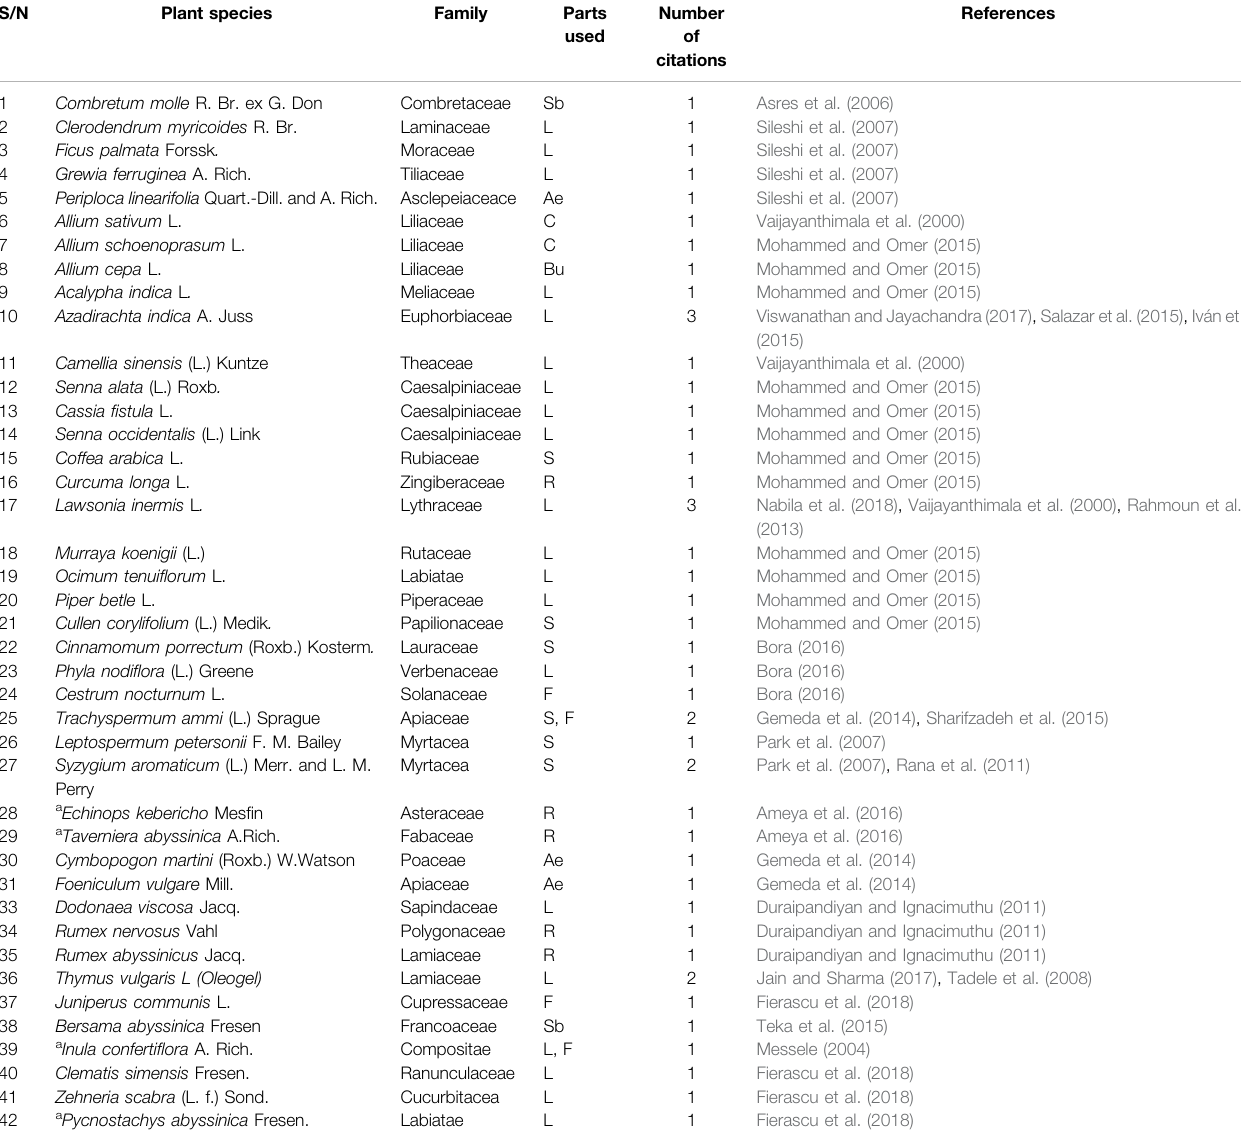
TABLE 2 | Summary of common medicinal plants identi fi ed from literature search for anti-fungal